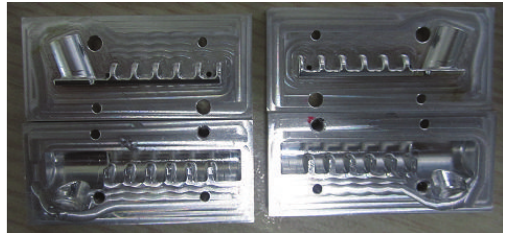
Figure 8: Fabricated convex and concave mold parts of